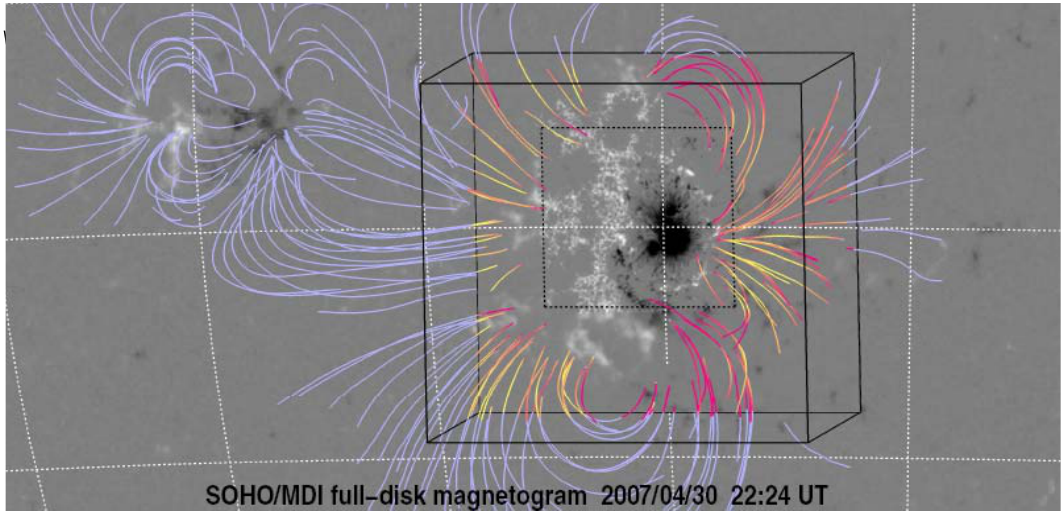
Fig. 8. SOHO/MDI magnetogram of AR 10953 with over-plotted stereoscopic reconstructed loops (see Aschwanden et al., 2008c) in blue and extrapolated non-linear force-free coronal magnetic field lines. The solid box depicts the 320 × 320 × 256 grid point simulation box in which the magnetic field extrapolations have been carried out. The dotted area depicts the field-of-view of Hinode/SOT-SP. Only in this dotted area photospheric vector magnetograms have been available. [Original published in (DeRosa et al., 2009) as part of figure 1].